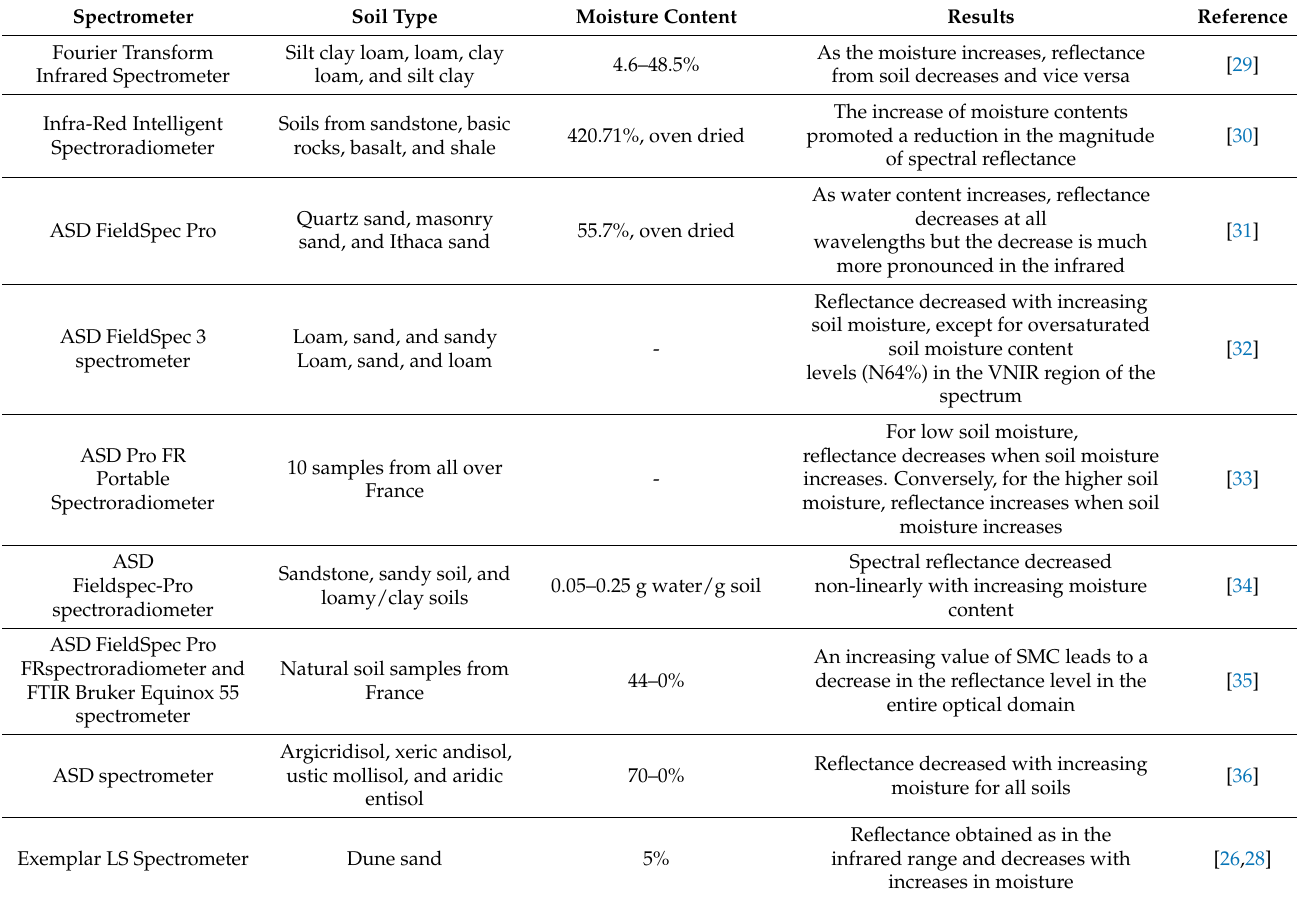
Table 3. Studies using spectrometers for soil moisture content determination.